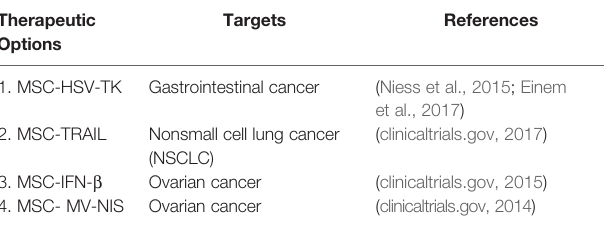
TABLE 1 | Mesenchymal stromal/stem cell (MSC) clinical trials targeting solid